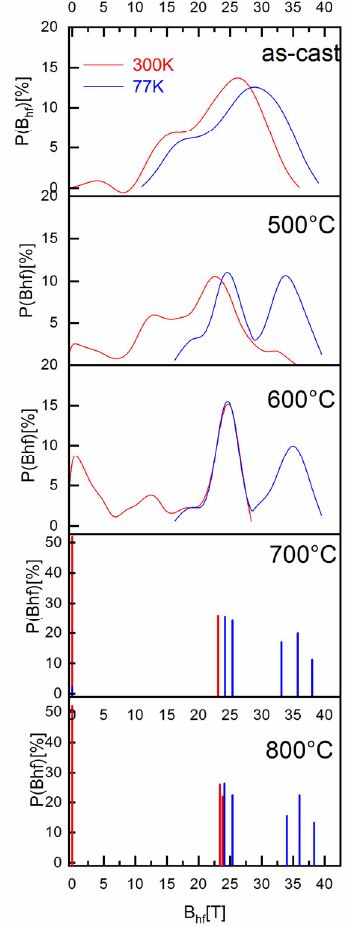
Figure 7. B hf distributions obtained for 300 K and 77 K spectra of samples annealed at 500–800 ◦ C for 20 min. The corresponding spectra are those depicted in Figure